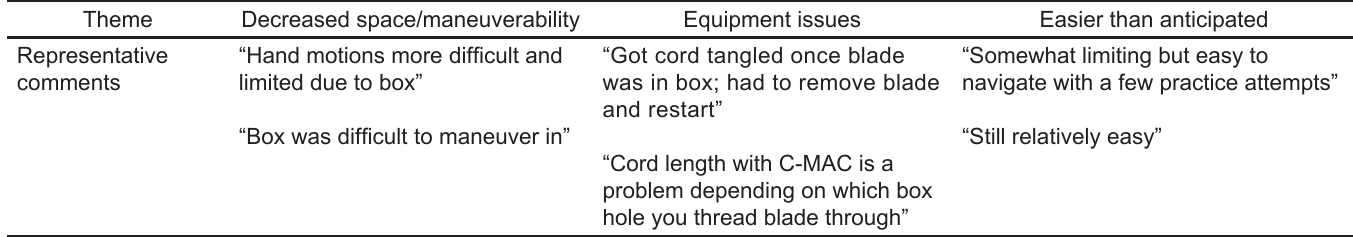
Table 3. Open-ended comments regarding use of transparent aerosol box during